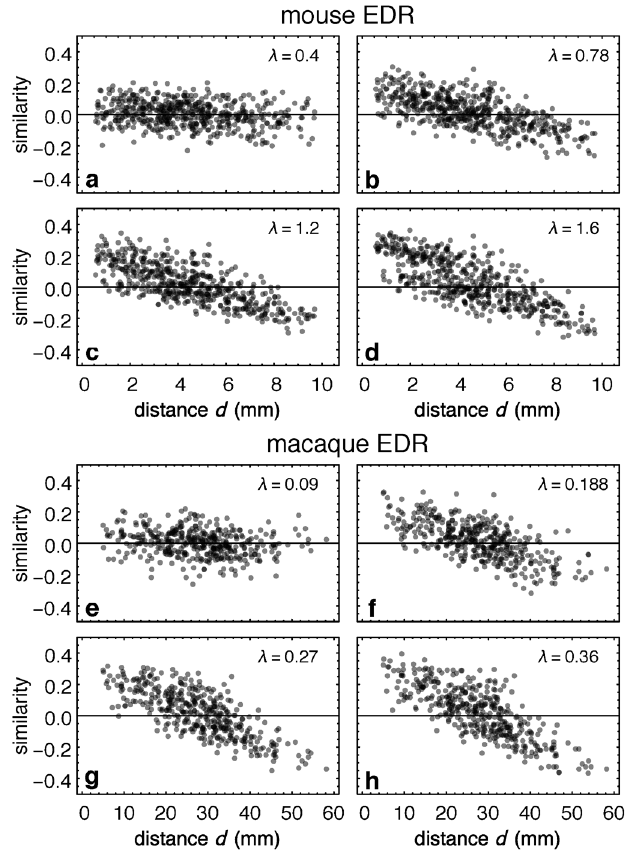
Fig 8. Mouse and macaque connection similarity indices in the EDR networks as function of the decay rate λ . (a – d) mouse, (e – h) for the macaque. Data points generated from a typical sample EDR model network for each